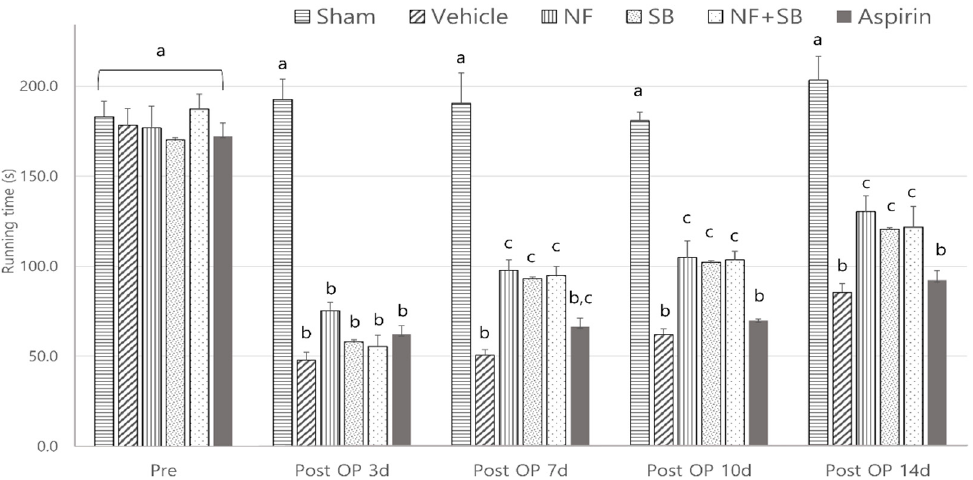
Figure 3. Effect of NF on Rotarod test at the 7th, 10th, and 14th day after the nerve crush injury. The NF treated group showed recovery of motor deficit and balance with increased riding time. Results are represented as mean ± SEM. Data were analyzed by ANOVA with Tukey’s post hoc analyses. Values with the different small letters (a–c) are significantly different among six treated groups within same time group at p < 0.05.